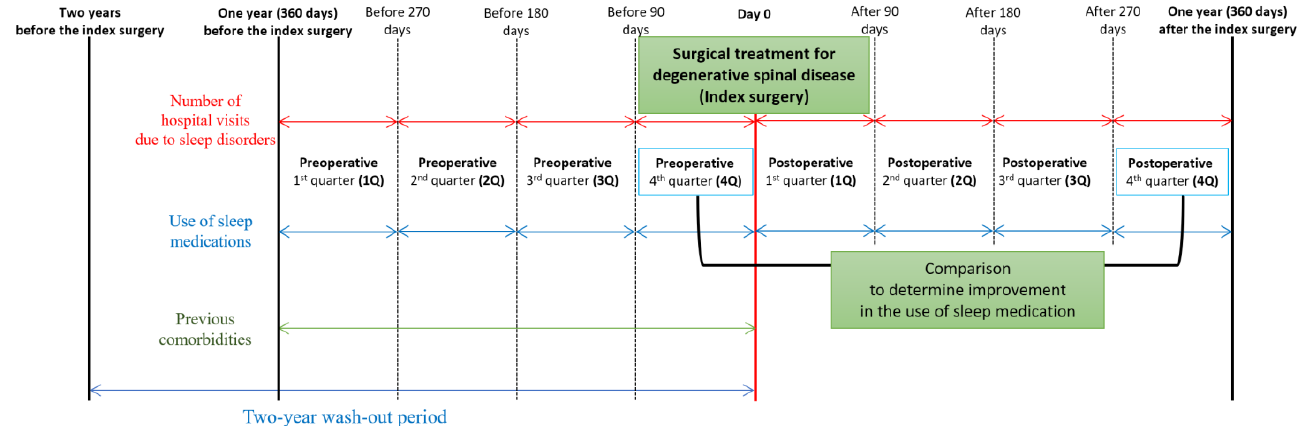
Figure 2. Study designs and definitions of the eight perioperative periods.